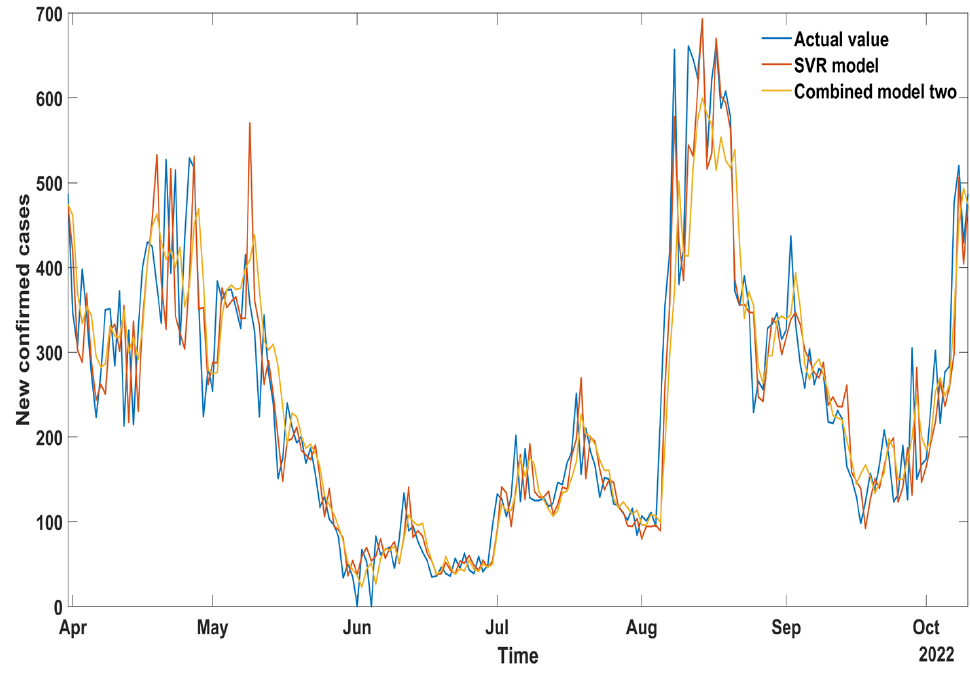
Figure 7. Comparison of the SVR model, combined model 2, and the true value.